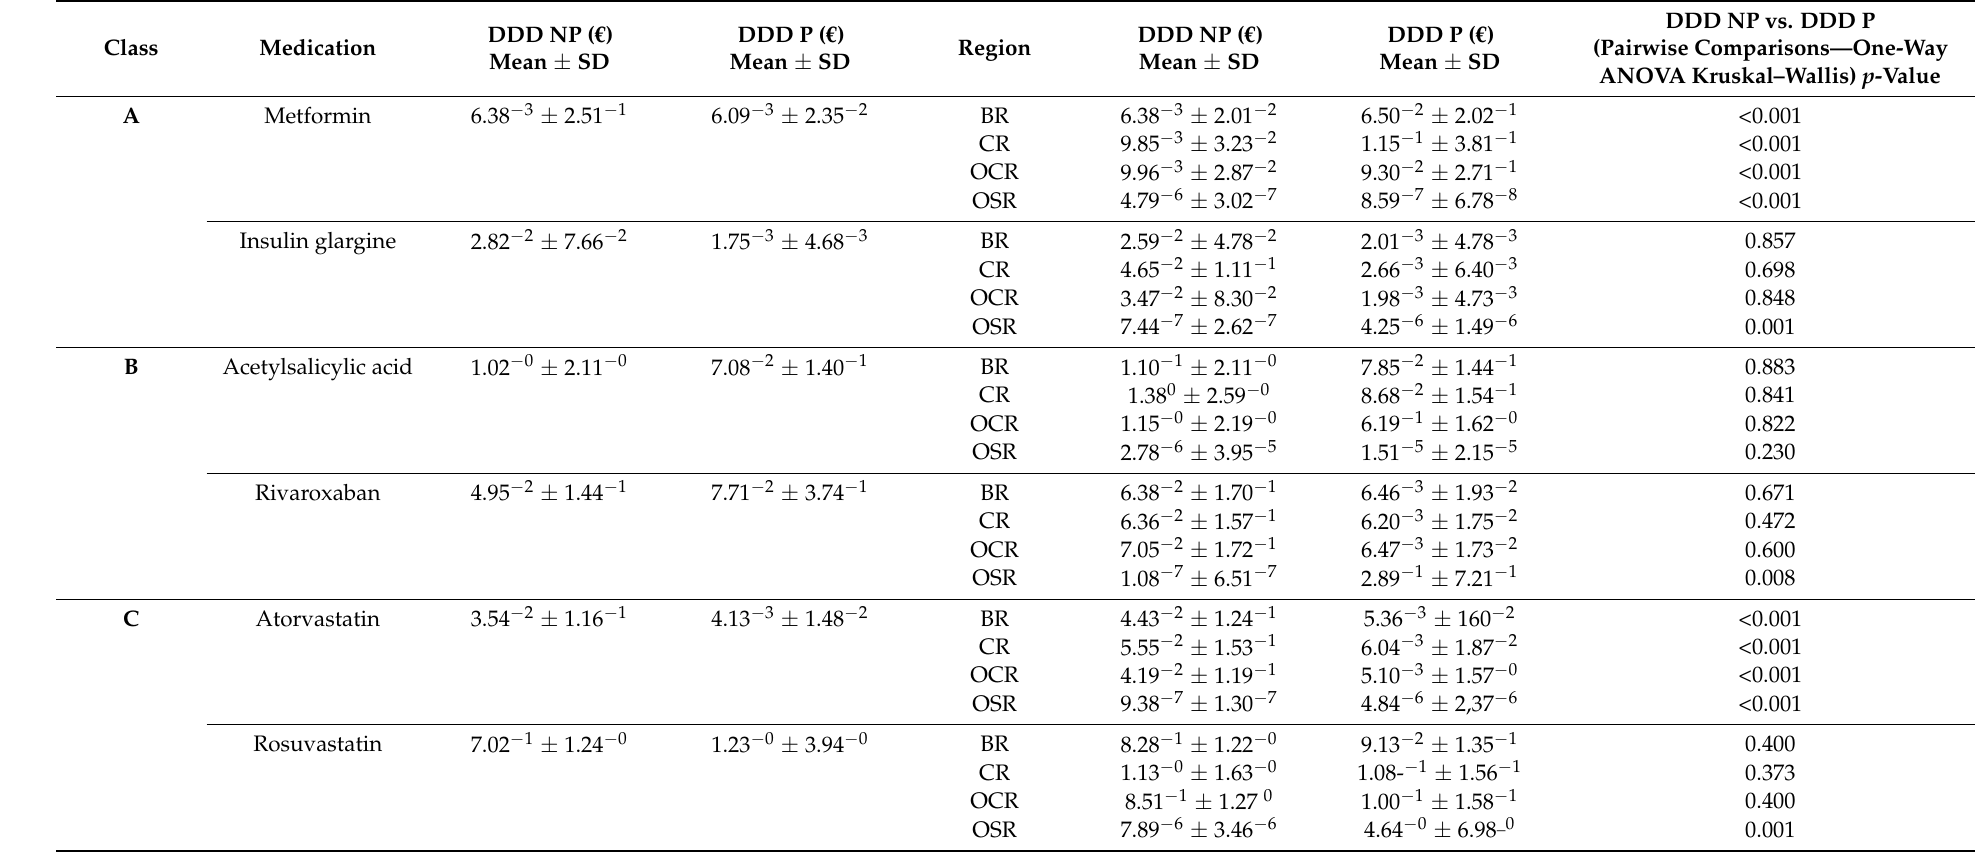
Table 1. Mean DDD for each medication in each precarious and non-precarious population group and in each